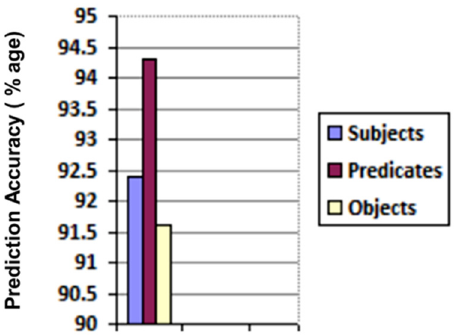
Figure 10. Prediction accuracy of subject/predicate/object in bi-LSTM returned triples.